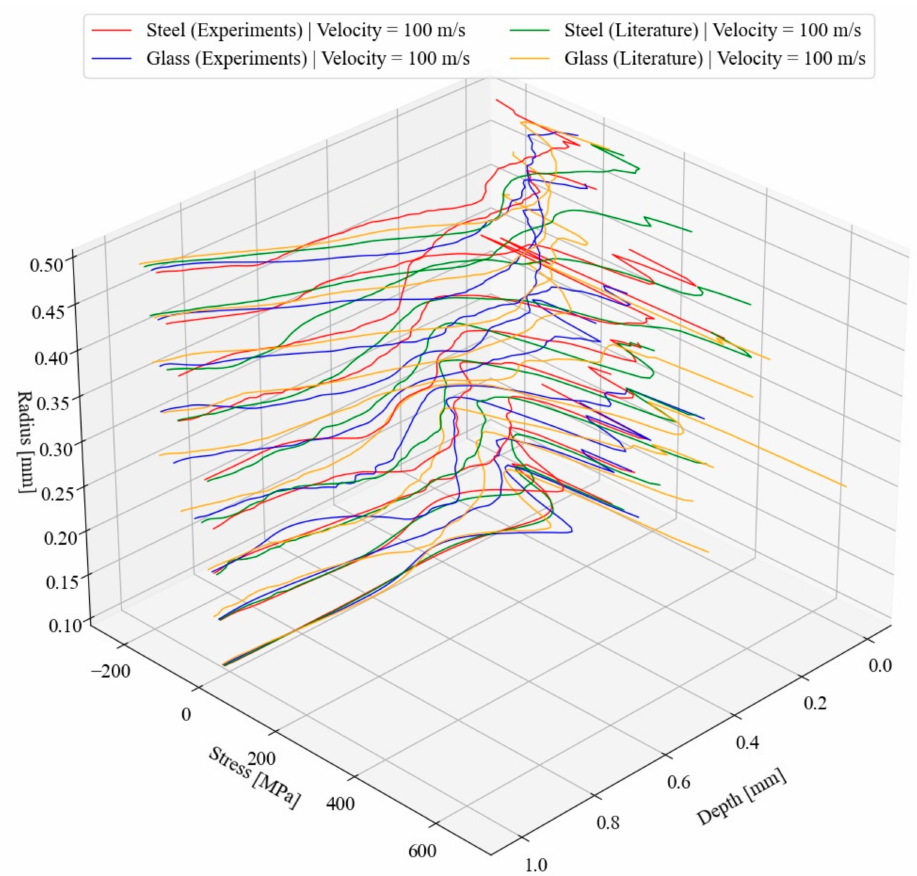
Figure 7. Resulting residual stress profiles for a defined velocity (100 m/s) for the same variations defined within Figure 7.